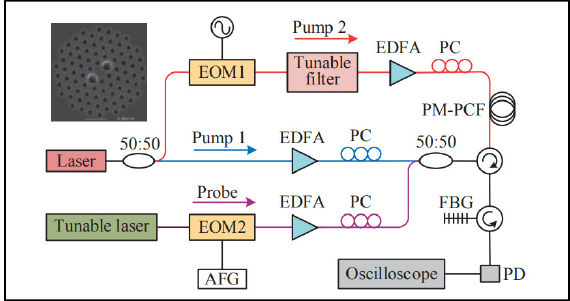
Figure 5. Experimental setup of distributed temperature and strain sensing using BDG and BGS. Reproduced from [31]. Copyright (2017) The Japan Society of Applied Physics.